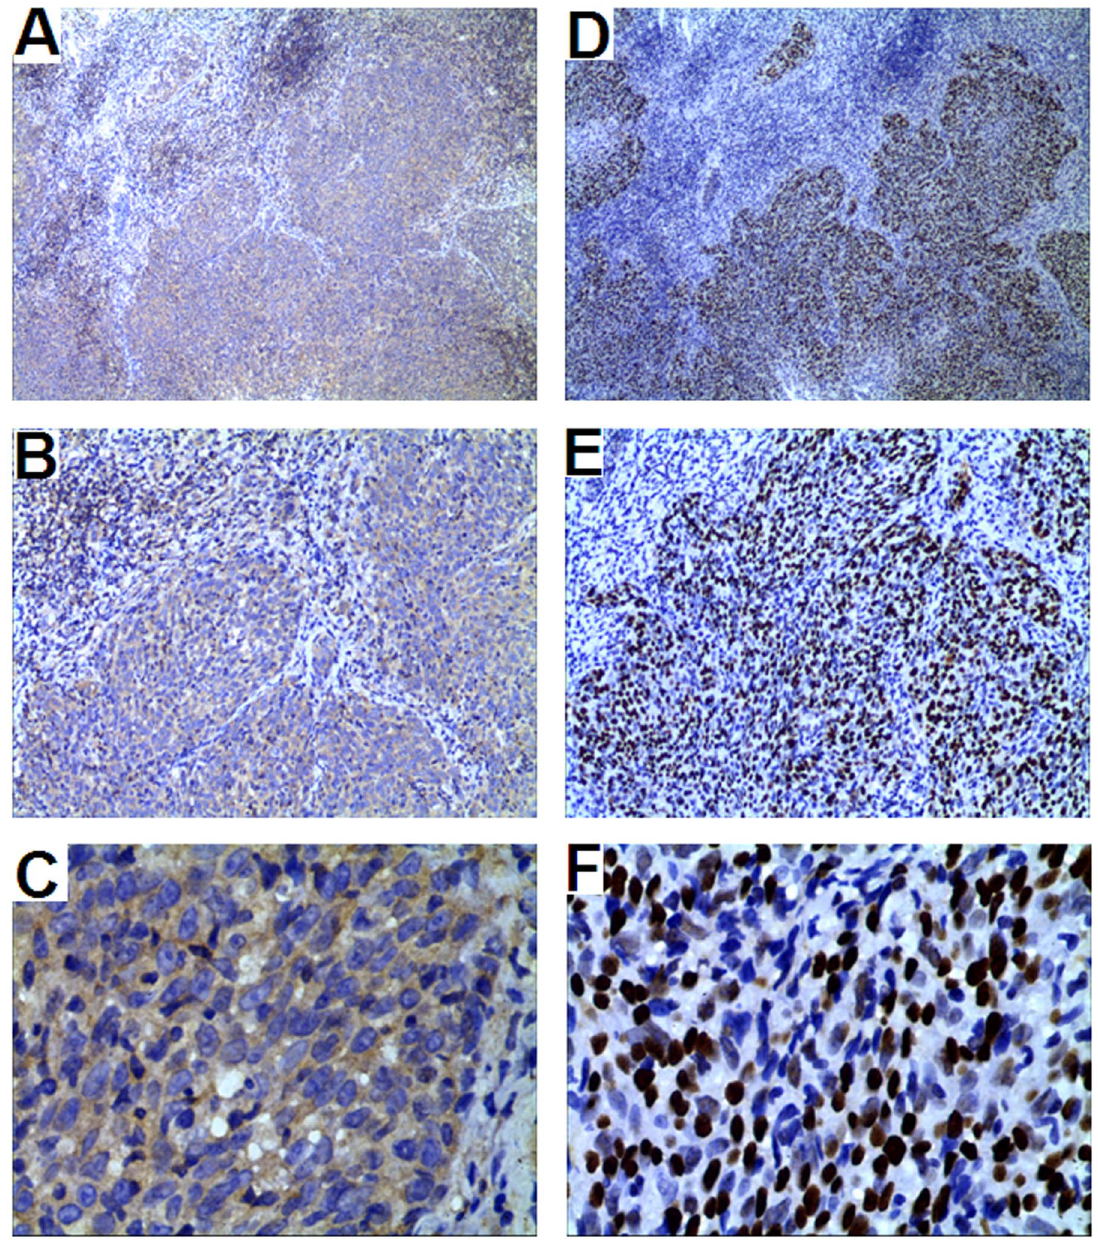
Figure 3. Immunohistochemical analysis of p53 and pAkt expression in NPC tissues. Brown cytoplasmic staining of tumor cells, indicative of positive pAkt, shown in A (x40), B (x100), and C (x400); Brown nuclear staining of tumor cells, indicative of positive p53, shown in D (x40), E (x100), and F (x400).